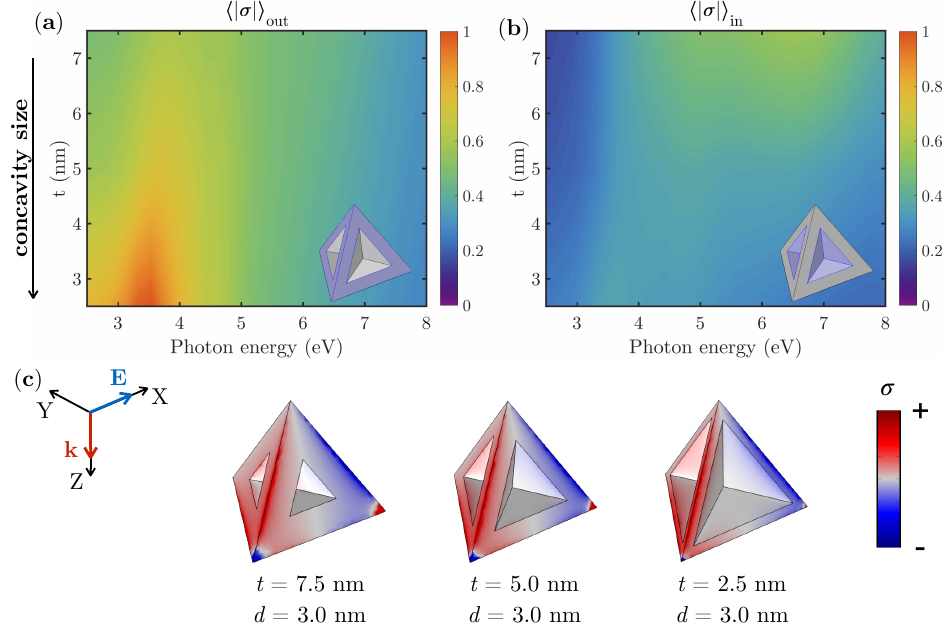
Figure 7. ( a ) Normalized spectral values of surface charge distribution ( σ ) averaged over the exterior faces and ( b ) over the concavity of the TDs as a function of the concavity size t while keeping its depth constant d = 3 nm. ( c ) Surface charge distribution ( σ ) over the concave Rh TDs. The red/blue regions represent positive/negative charge